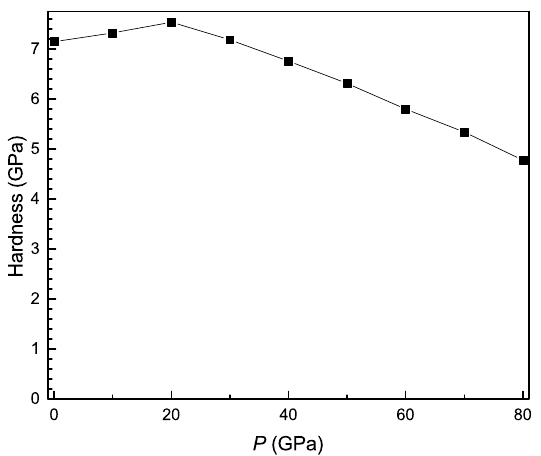
Figure 6. Hardness as a function of pressure for Ti 3 Al.